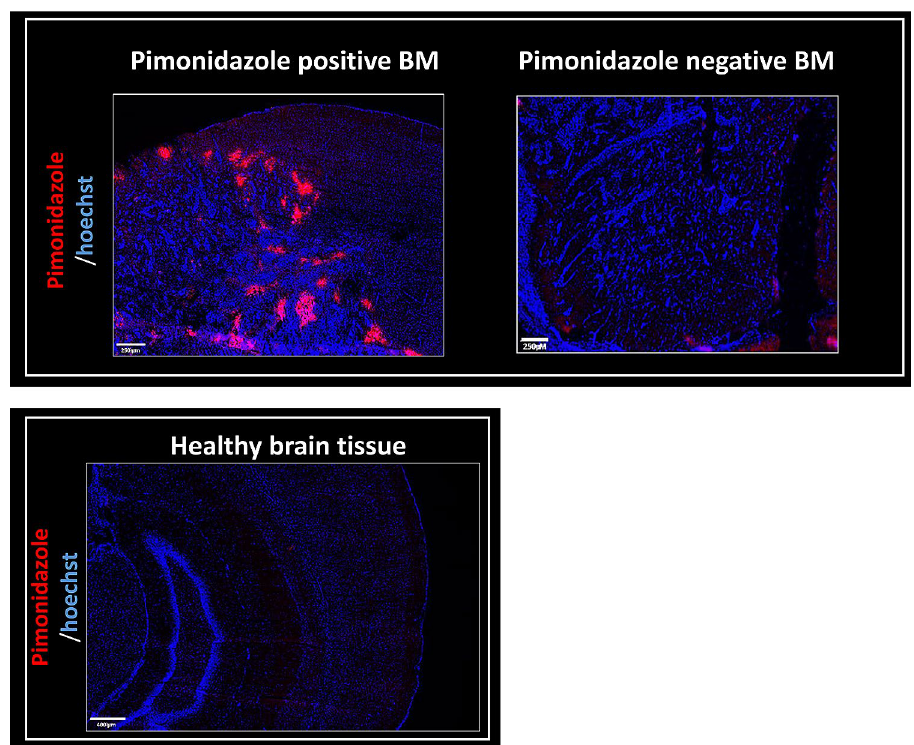
Figure 4. Pimonidazole detection by immunohistology in preclinical models of BM with intracardiac injection of human lung cancer (H2030-Br3M). Representative images of pimonidazole staining (red) with a Hoechst 33342 nuclear counterstaining (blue) on BM model from human lung adenocarcinoma (H2030-Br3M) and one healthy